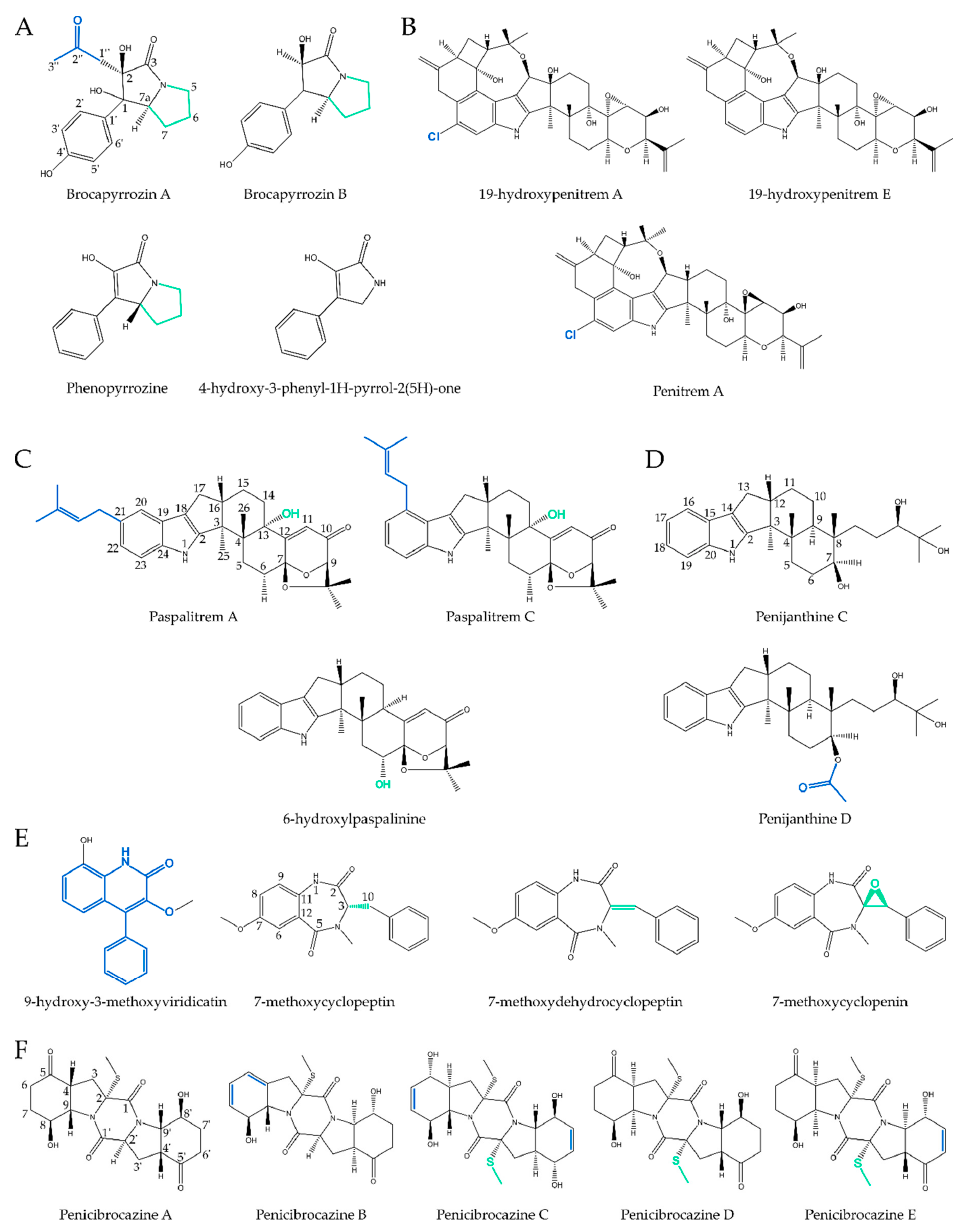
Figure 10. Structure–activity analysis of newly discovered antimicrobial alkaloids discussed in this review. ( A ) Structural comparison of brocapyrrozin A and B, phenopyrrozin, and 4-hydroxy-3-phenyl-1 H -pyrrol-2(5 H )-one. The acetonitrile group on C-2 (blue) and the absence of the pyrrole group (green) probably increase the fungicidal activity. ( B ) Structural comparison of penitrem A and its derivatives, 19-hydroxypenitrem A and 19-hydroxypenitrem E. The presence of a chlorine atom (blue) most likely elevates antibacterial activity. ( C ) Structural comparison of paspalitrem A, paspalitrem C, and 6-hydroxylpaspalinine. The differences between the structures are highlighted in blue and green. ( D ) Structural overview of penijanthines C and D. The acetoxy group at C-7 (blue) of penijanthine D probably lowers anti- Vibrio activity. ( E ) Structural overview of 9-hydroxy-3-methoxyviridicatin and the cyclopeptin derivatives. The viridicatin (blue) structure is proven to be a promising antibacterial compound core, worth looking further into, while the cyclopeptin antimicrobial activity could be dependent on the chirality of its C-3 atom (green). ( F ) Structural comparison of penicibrocazines A–E. The lack of double bonds (blue) and / or S -methyl group at C-2 (cid:48) (green) might explain the absence of antimicrobial activity of penicibrocazine A compared to penicibrocazines